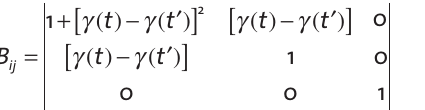
Table 2 (left): The relaxation spectrum for 6-week-old Cheddar and Mozzarella cheeses based on small amplitude oscillatory shear test data. Figure 1 (right): Discrete relaxation spectrum for 6-week-old reduced-fat Mozzarella at 40˚C and g 0